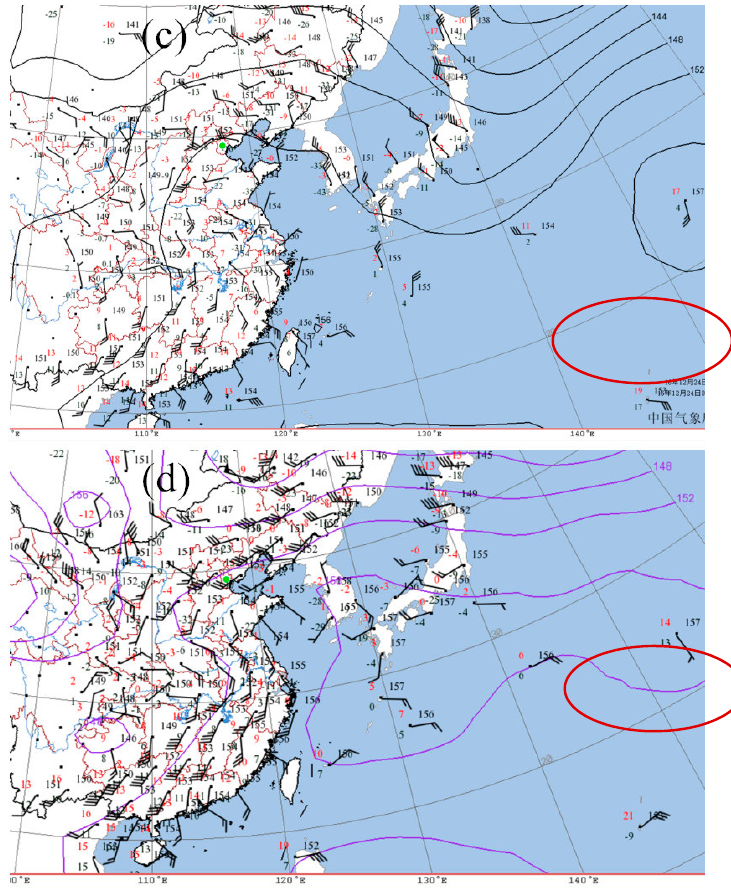
Figure 3. ( a ) Profile of wind speed obtained from wind-profile radar from 0000 UTC (LST = UTC + 8) to 2300 UTC 24 December. ( b ) Profiles of water vapor density from 0000 UTC 24 December to 1200 UTC 25 December 2016. The contour charts and observations of meteorological parameters at 850 hPa ( c ) at 0800 LST 24 December and ( d ) at 0800 LST 25 December obtained from CMA (The green dot denotes the Meteorological Observation Station in